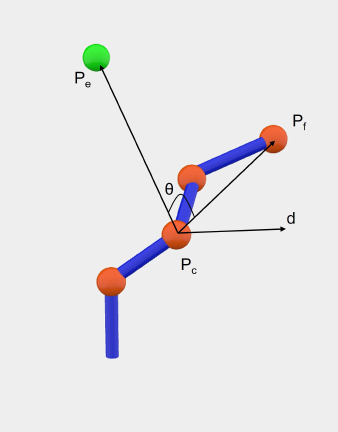
Figure 20. Vector definition for the CCD